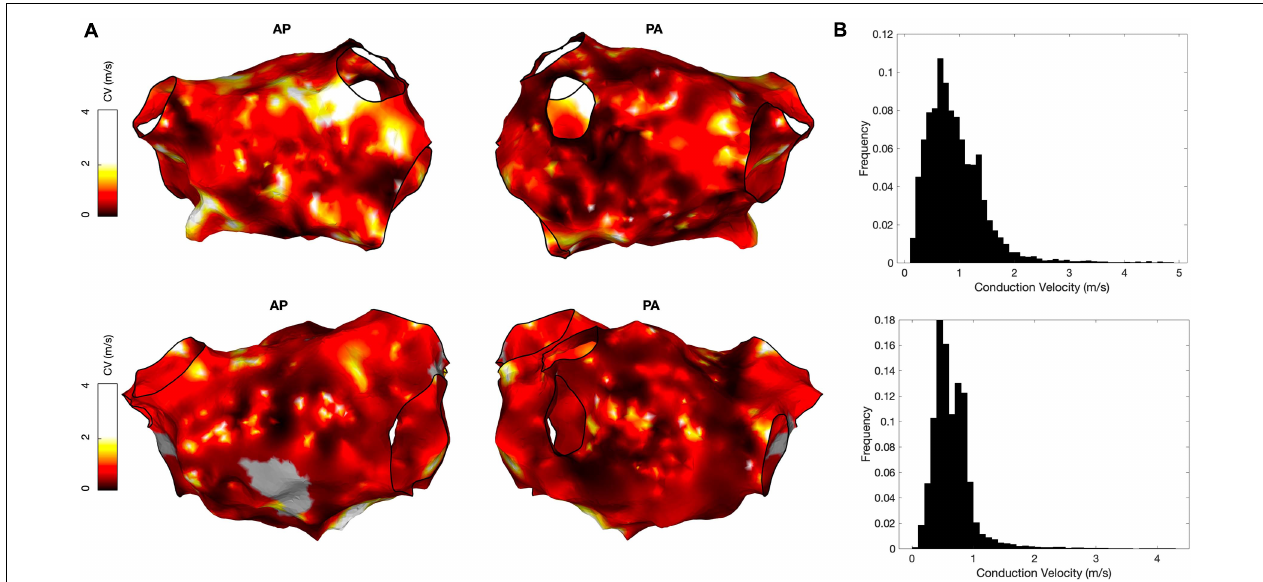
FIGURE 8 | Conduction velocity measurement using OpenEP software. (A) Conduction velocity maps of two cases in anterior-posterior orientation (left) and postero-anterior orientation (right). Maps created using the OpenEP function: drawMap(userdata, 'type', 'cv', 'coloraxis', [0 2], 'orientation', 'pa') . (B) Conduction velocity histograms corresponding to the maps in panel A; created using the OpenEP function call: cvHistogram(userdata). CV, conduction velocity; AP, antero-posterior; PA, postero-anterior.